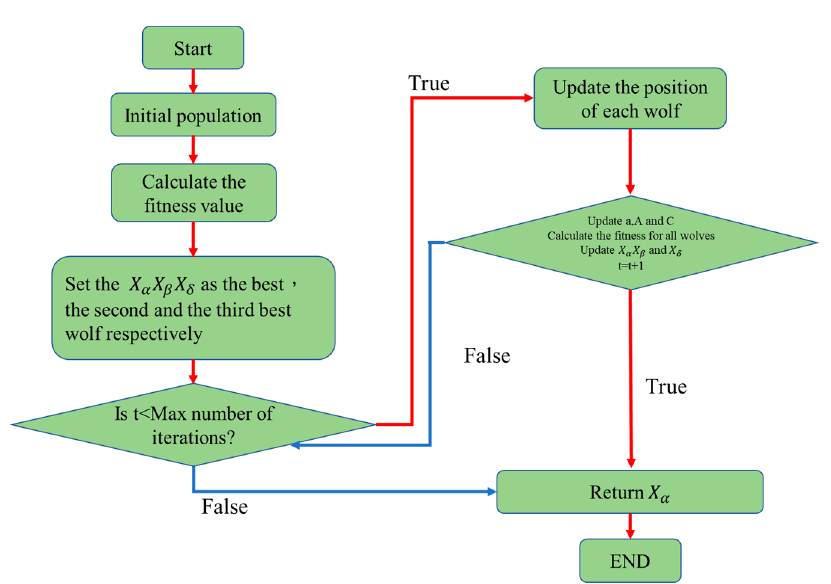
Figure 10. Conceptual representation of the GWO algorithm.